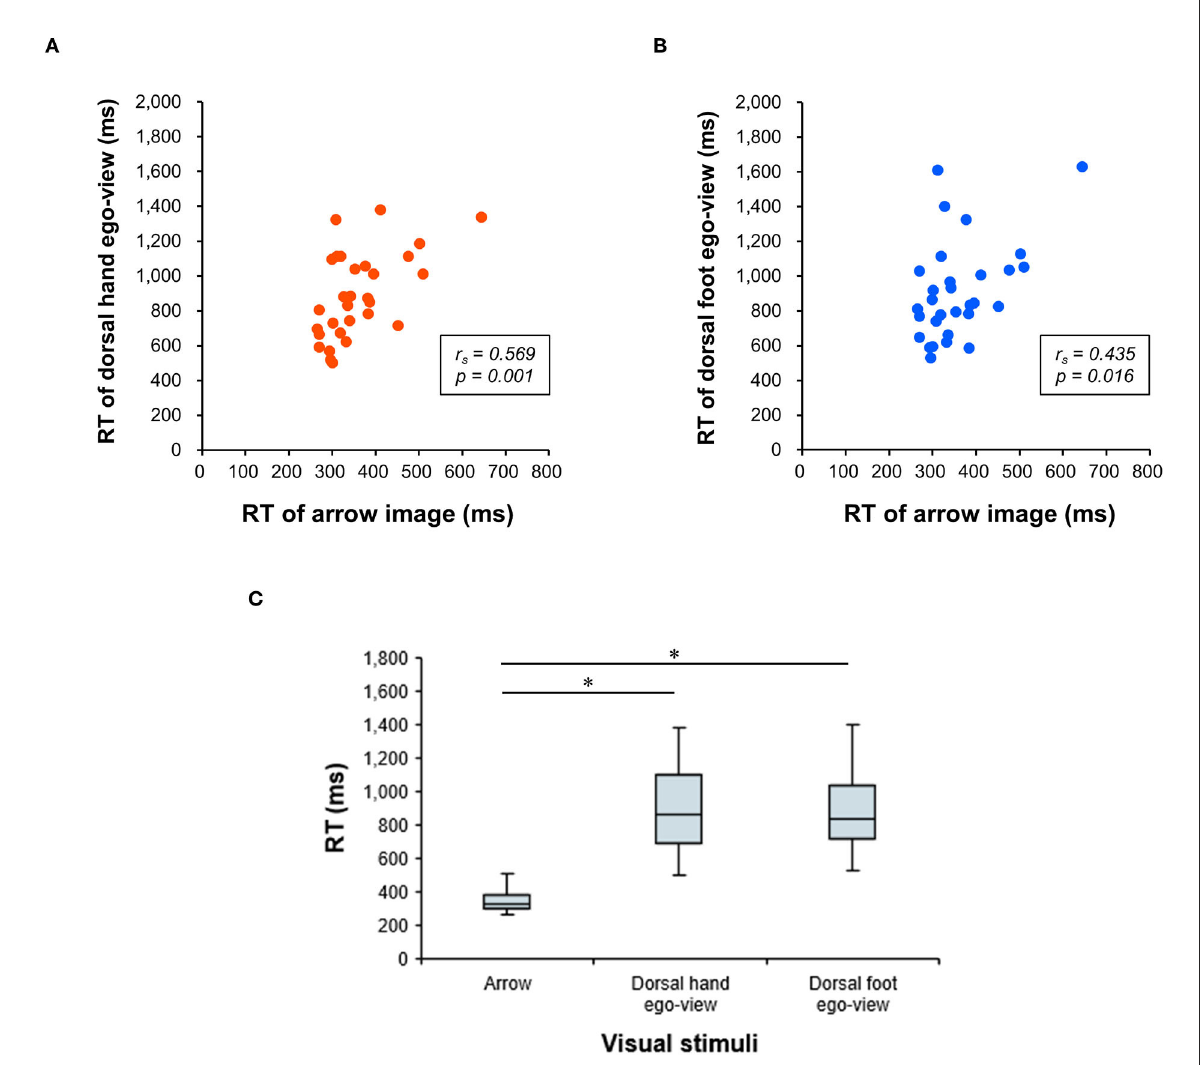
FIGURE4 Relationship between RTs of the arrow and dorsal hand/foot images in the egocentric view. Results of the correlation analysis are depicted in the upper row. The x-axis denotes the response time (RT) for the arrow image. The y-axis denotes the RT for the egocentric perspective (ego-view) in the dorsal hand image (A) or that for the ego-view in the dorsal foot image (B) , respectively. (C) Results of comparisons among the RTs of three visual stimuli (arrow, hand, and foot images) are depicted on the lower row. The x-axis denotes a condition of the visual stimuli. The y-axis denotes the RT. * Significant differences with p <